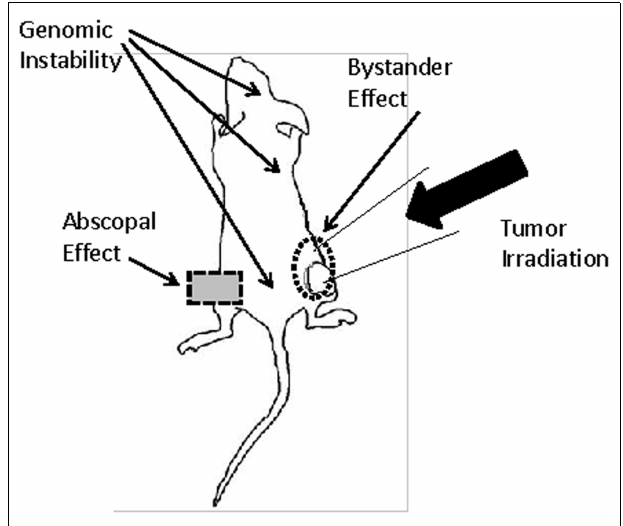
FIGURE 1 |The graph shows the different potential routes by which bystander, abscopal effects, and genomic instability may affect the outcome of radiation therapy in a tumor mouse model. Radiation-induced DNA damage in the tumor can be amplified by bystander signals in cells residing in close proximity to the irradiation field. In contrast, abscopal effects and genomic instability exert distant and systemic